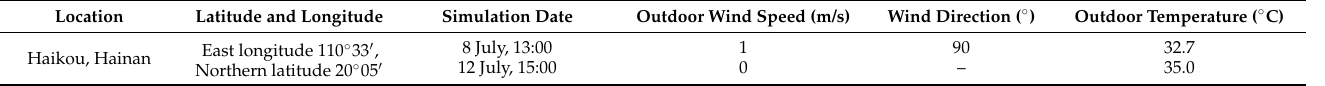
Table 3. Parameter setting of the simulation environment.